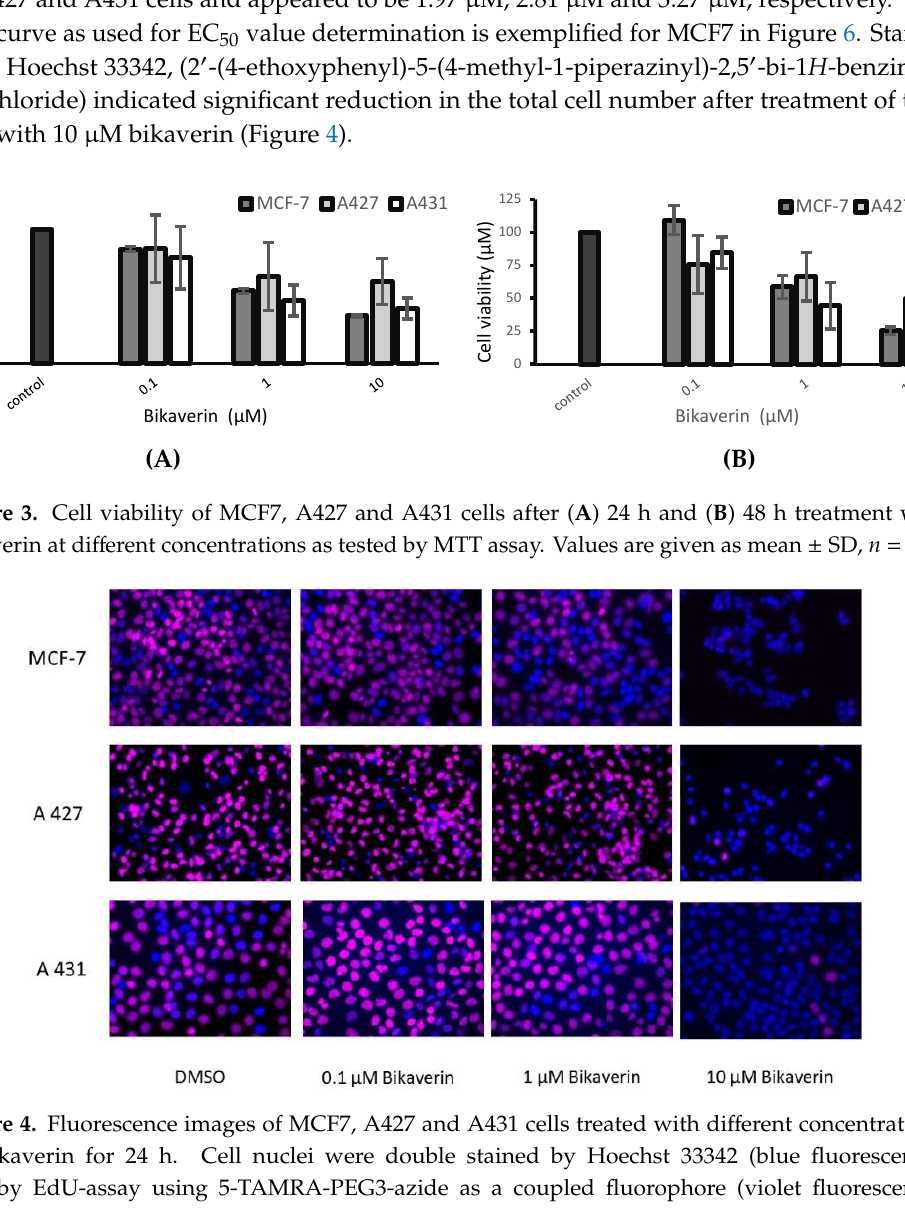
of Hoechst-stained cells and TAMRA-labeled proliferating cells. The cells that are emitting only